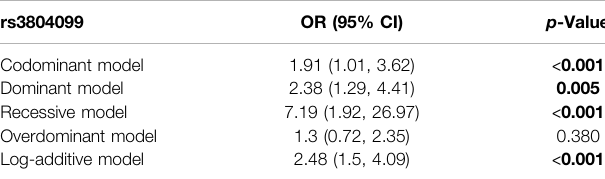
TABLE 3 | Results of multiple inheritance models in rs3804099 adjusted by the administration of sirolimus in fi ve